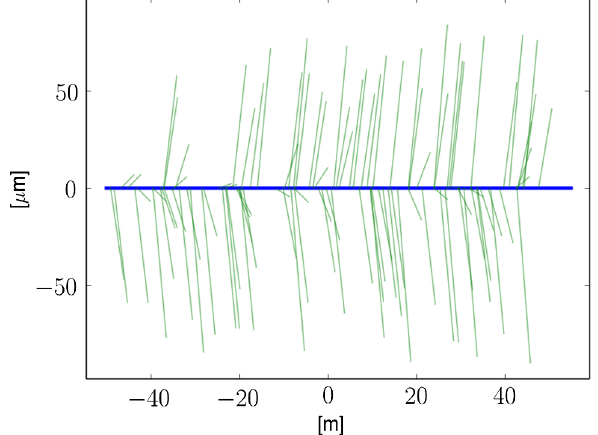
FIG. 2. Electron (blue) and photon (green) trajectories, for